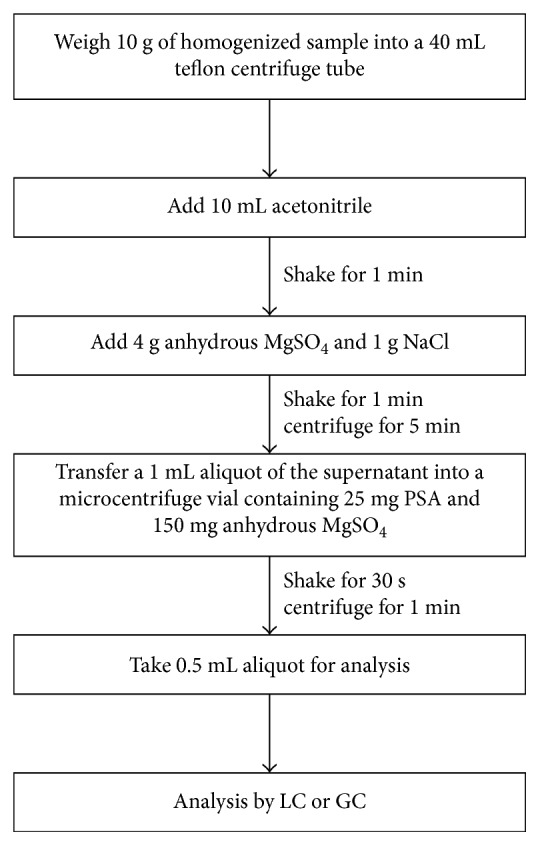
Flowchart of the QuEChERS method (based on [1] and [2]).